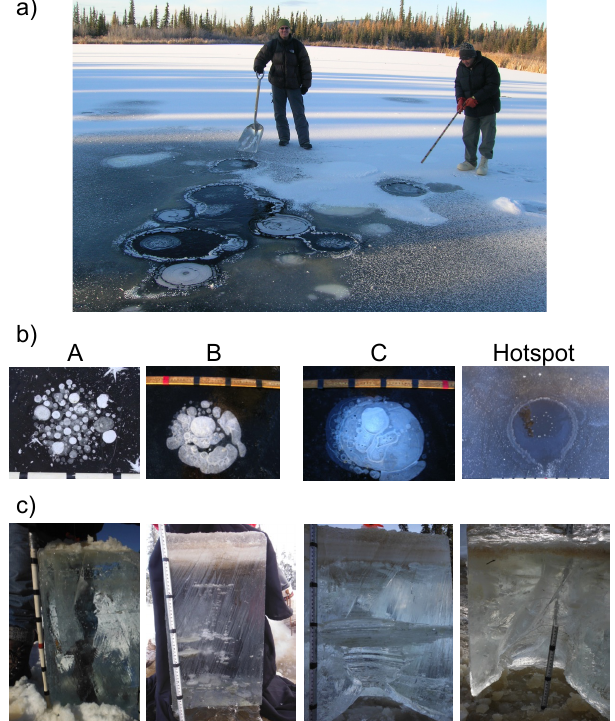
Figure 1. (a) Photograph showing CH 4 -rich bubbles trapped by ice at Goldstream Lake in mid-October 2007. (b) Photographs of repre- sentative A-, B-, C-, and Hotspot-type seep sites as seen from above in early-winter lake ice. Note the open water at the Hotspot seep site. The black and red markings on the rulers shown are 10cm apart. (c) Side-view photographs of blocks of ice harvested from above seep sites in spring. Note the hollow cavity in the block harvested from above the Hotspot seep site (at